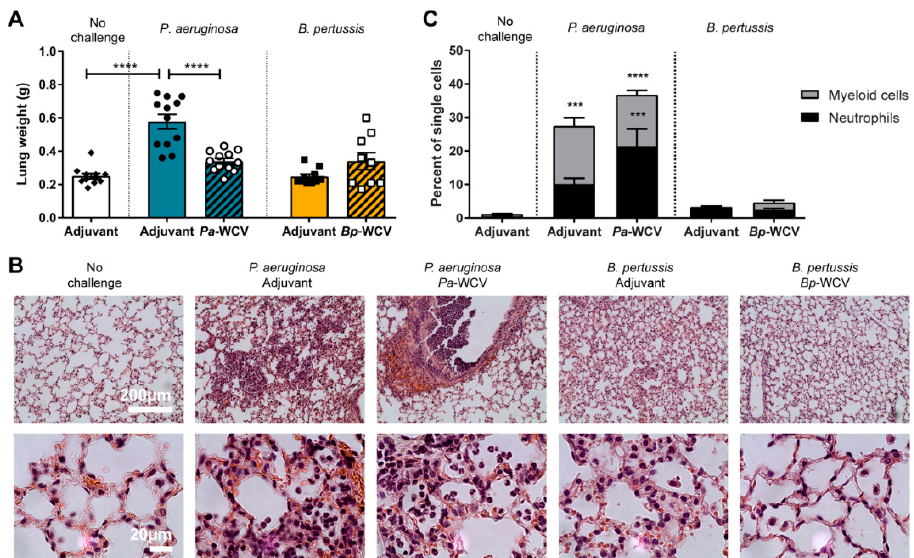
Figure 3. Signs of inflammation in the lung after-challenge. ( A) . The lung masses of mice groups at 16 h. post-challenge. ( B ). Hematoxylin and eosin (H & E) stained post-challenge lung sections imaged at 20 × and 100 × magnification. ( C ). Proportion of myeloid (CD11b + GR-1 + ) and neutrophil (CD11b + GR-1 high ) cell populations in single cells of lung homogenates ( n = 10–12 per group). The asterisks represent a comparison of the indicated bar to adjuvant-only non-challenge, and bars indicate statistical significance determined by ANOVA: *** p ≤ 0.001, **** p ≤